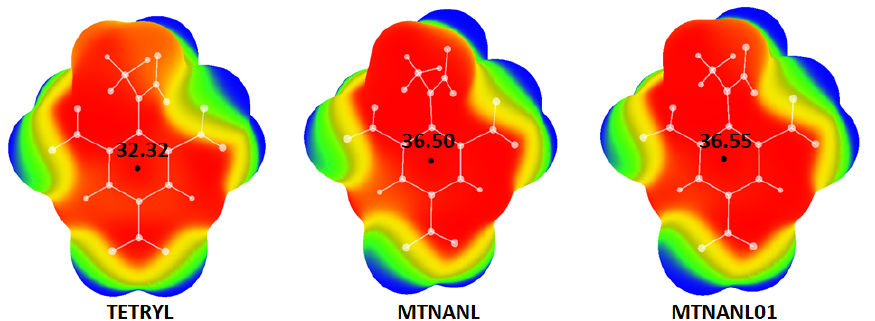
Figure 6. Electrostatic potential maps calculated for the optimized geometry (TETRYL) and geometries of TETRYL molecule found in crystal structures achieved in CSD (MTNANL and MTNANL01). Color ranges (in kcal/mol): red, greater than 20.90, yellow, from 0.00 to 20.90, green, from − 6.99 to 0.00, and blue, more negative than 6.99.